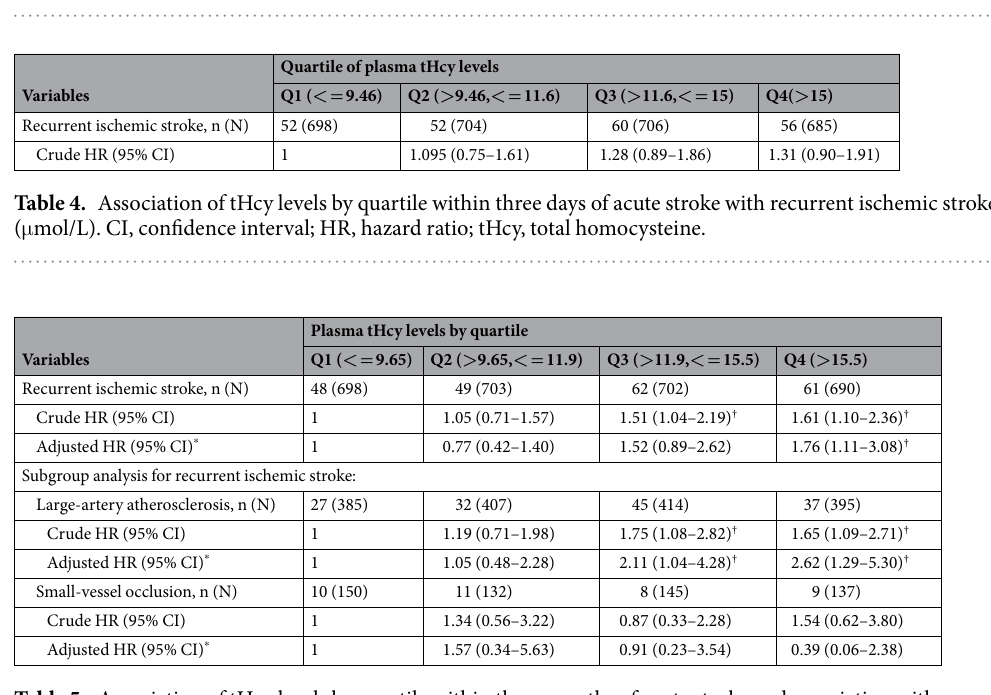
Table 3. Changes in tHcy levels within three months after acute stroke according to TOAST subtypes, stenosis, and age ( μ mol/L).